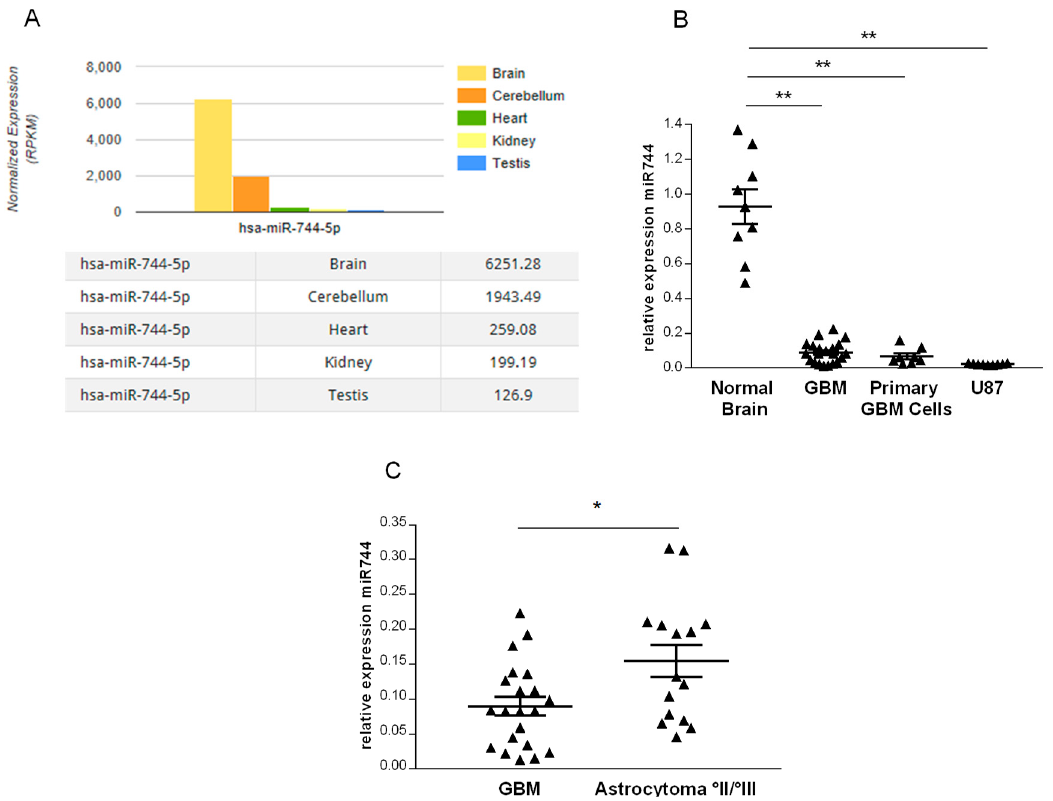
Figure 1. miR-744 is strongly repressed in glioma. MiR-744 expression was quantified by qRT-PCR. U47 served as the endogenous reference. ( A ) Expression levels of miR-744 in five different tissues. ( B ) Expression of miR-744 in normal brain tissue (NB) (n = 9), glioblastoma (GBM) (n = 21), primary GBM cell lines (n = 9), and U87 cells (n = 9), p < 0.001. ( C ) Expression of miR-744 in WHO grade °II/°III glioma (n = 15) compared to GBM (n = 21), p = 0.034. ** p < 0.001; * p < 0.05.